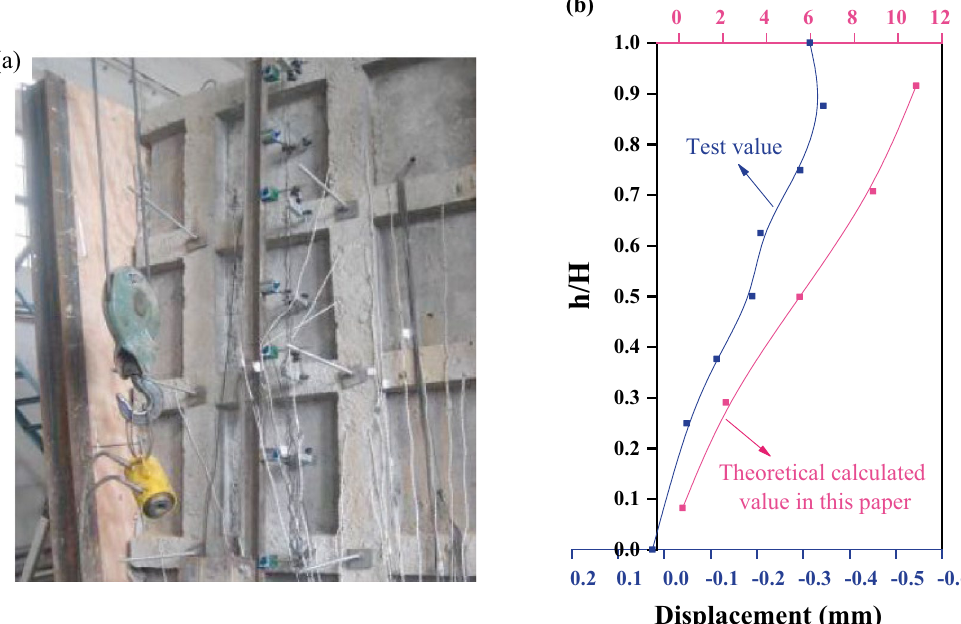
Figure 8. Horizontal displacement of slope supported by frame prestressed anchors 18 ( a ) Indoor test; ( b ) Displacement